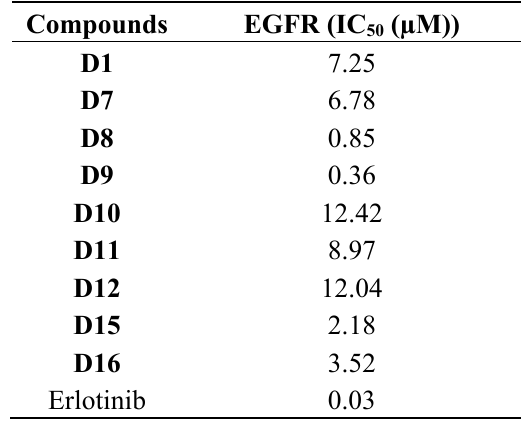
Figure 2. Correlation between the anti-proliferation against HepG2 cell line and EGFR inhibitory activity, R 2 =